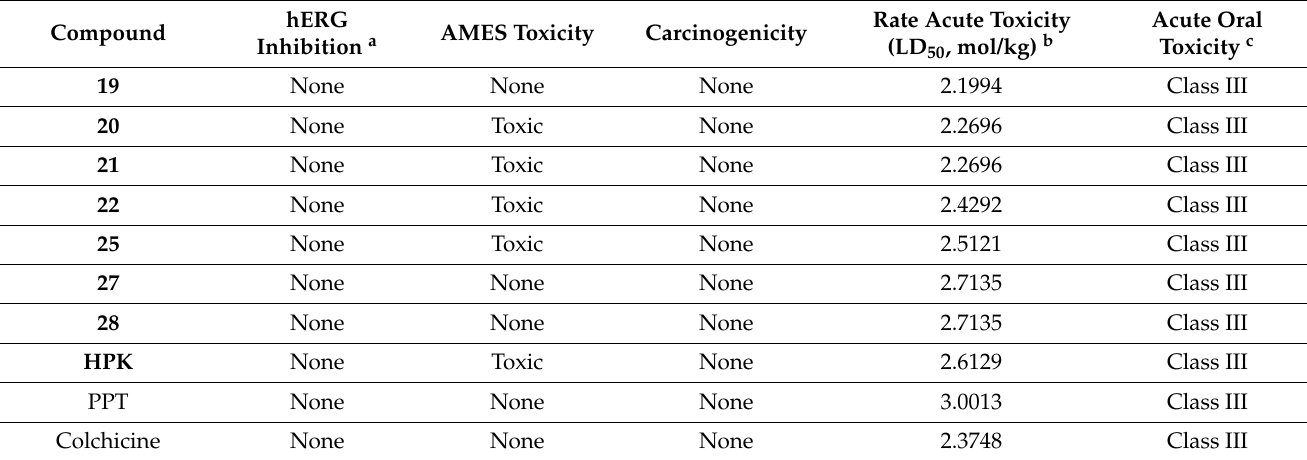
Table 8. Toxicity analysis of 4-PQ compounds, podophyllotoxin (PPT), and colchicine was evaluated by admetSAR